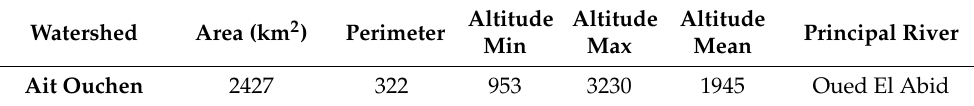
Figure 1. The geographical setting of the study area. Table 1. General characteristics of Ait Ouchen